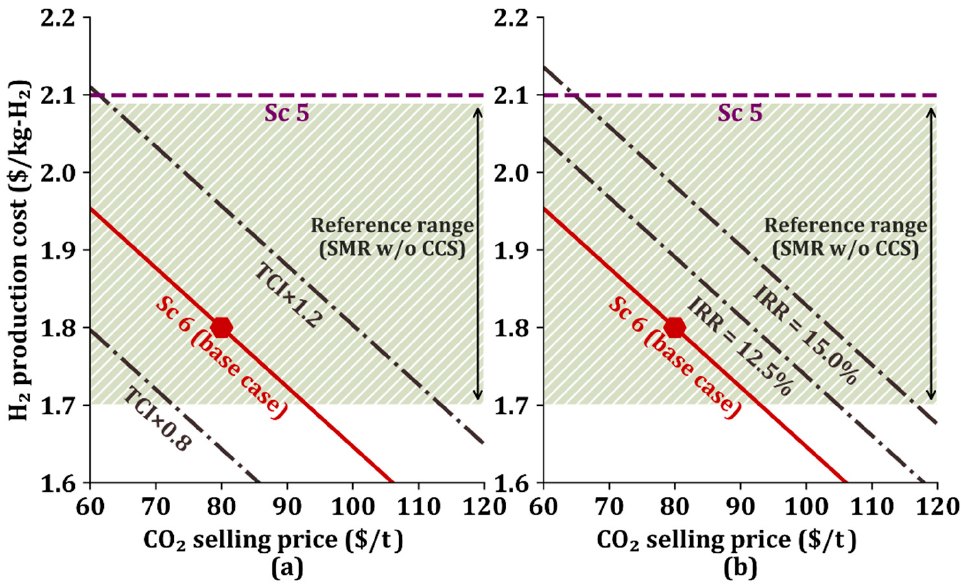
Figure 5. Viability envelope according to changes in ( a ) total capital investment (TCI) and ( b ) inter- nal rate of return (IRR) in Sc 6. The reference range is between $1.7/kg-H 2 and $2.09/kg-H 2 .